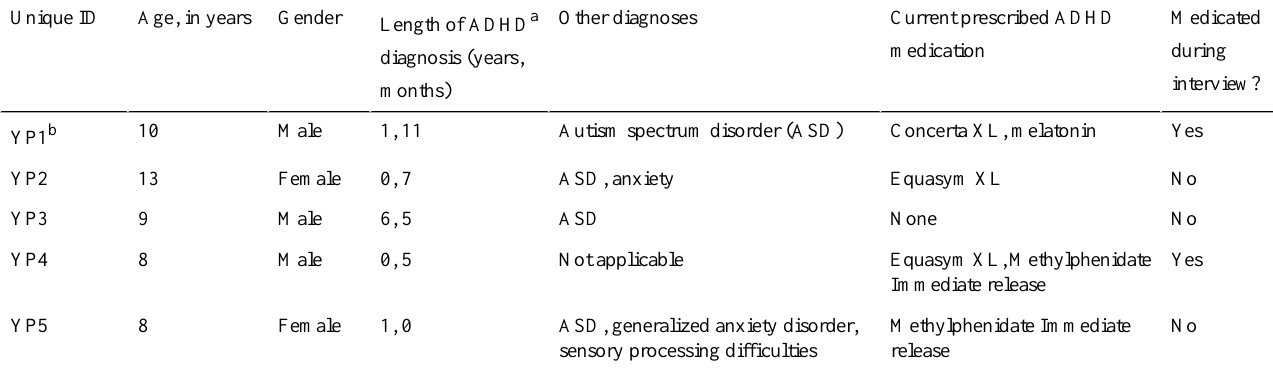
Table 4. Demographic characteristics of young